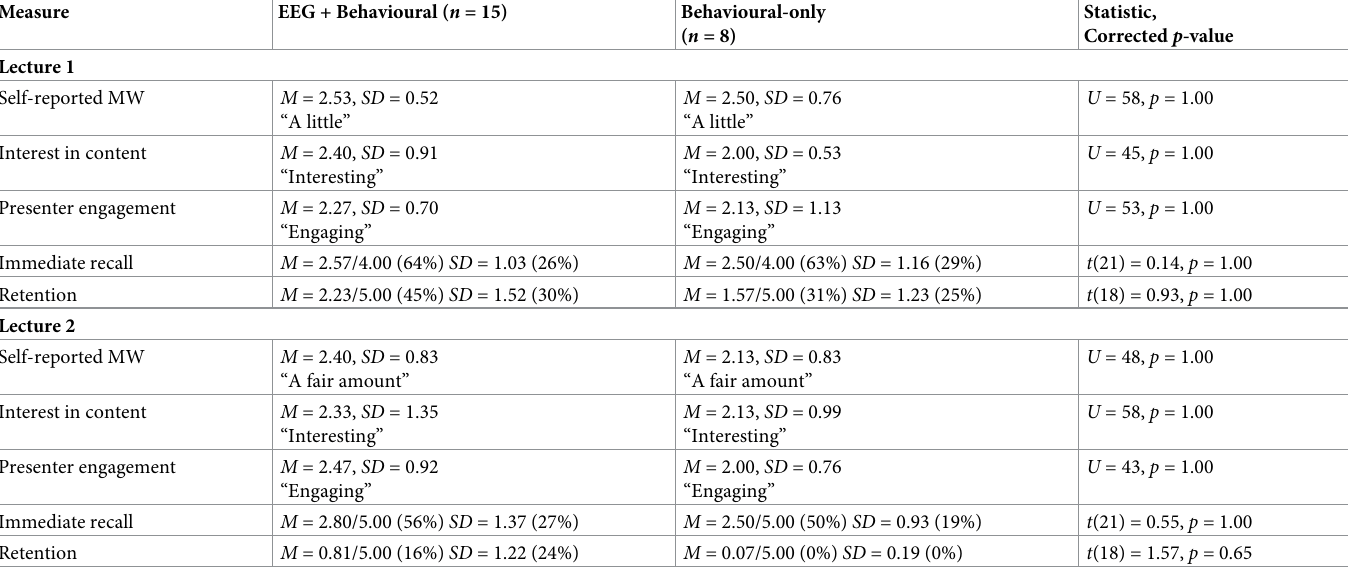
Table 3. Comparison of EEG and non-EEG participants on various